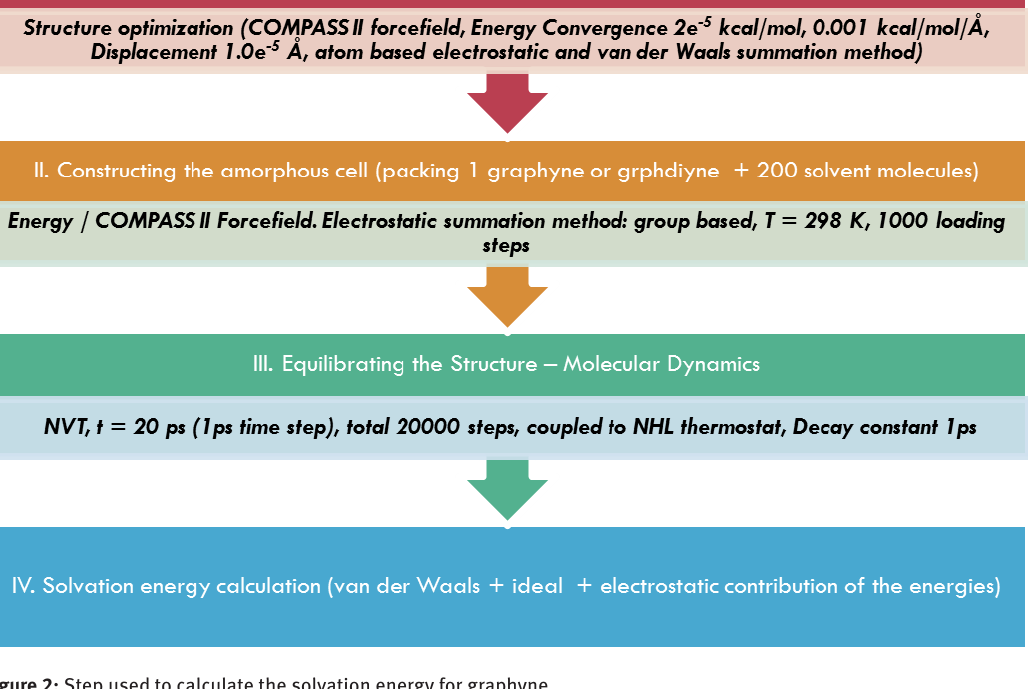
Figure 2: Step used to calculate the solvation energy for graphyne.